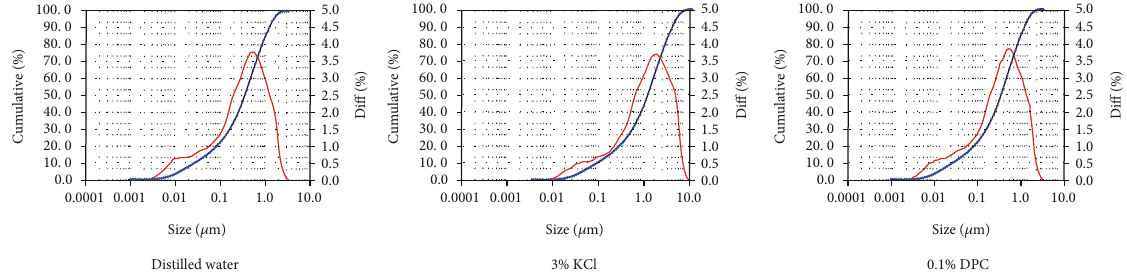
Figure 12: Distribution of solid particles in distilled water after pollution. Table 4: Particle size and content distribution of the solid phase in the working liquid system after pollution. Particle size ( μ